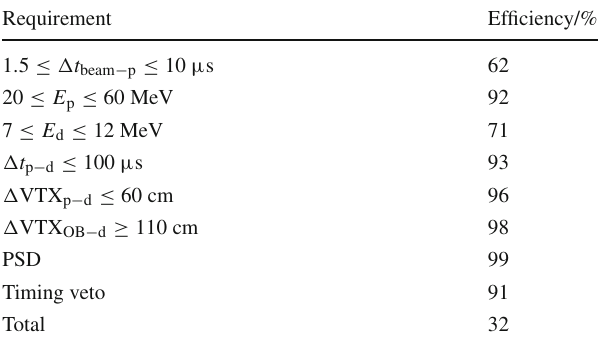
Table 1 The IBD selection criteria and their efficiencies in the JSNS 2 experiment [8]. Note that due to the data taking strategy in